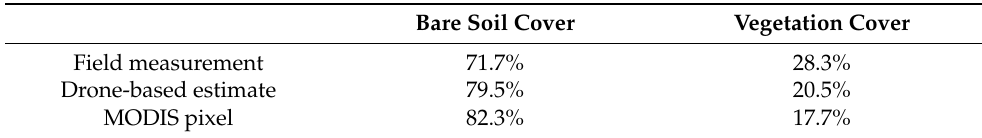
Table 4. The bare soil cover and vegetation cover from field measurement, drone-based estimate, and MODIS